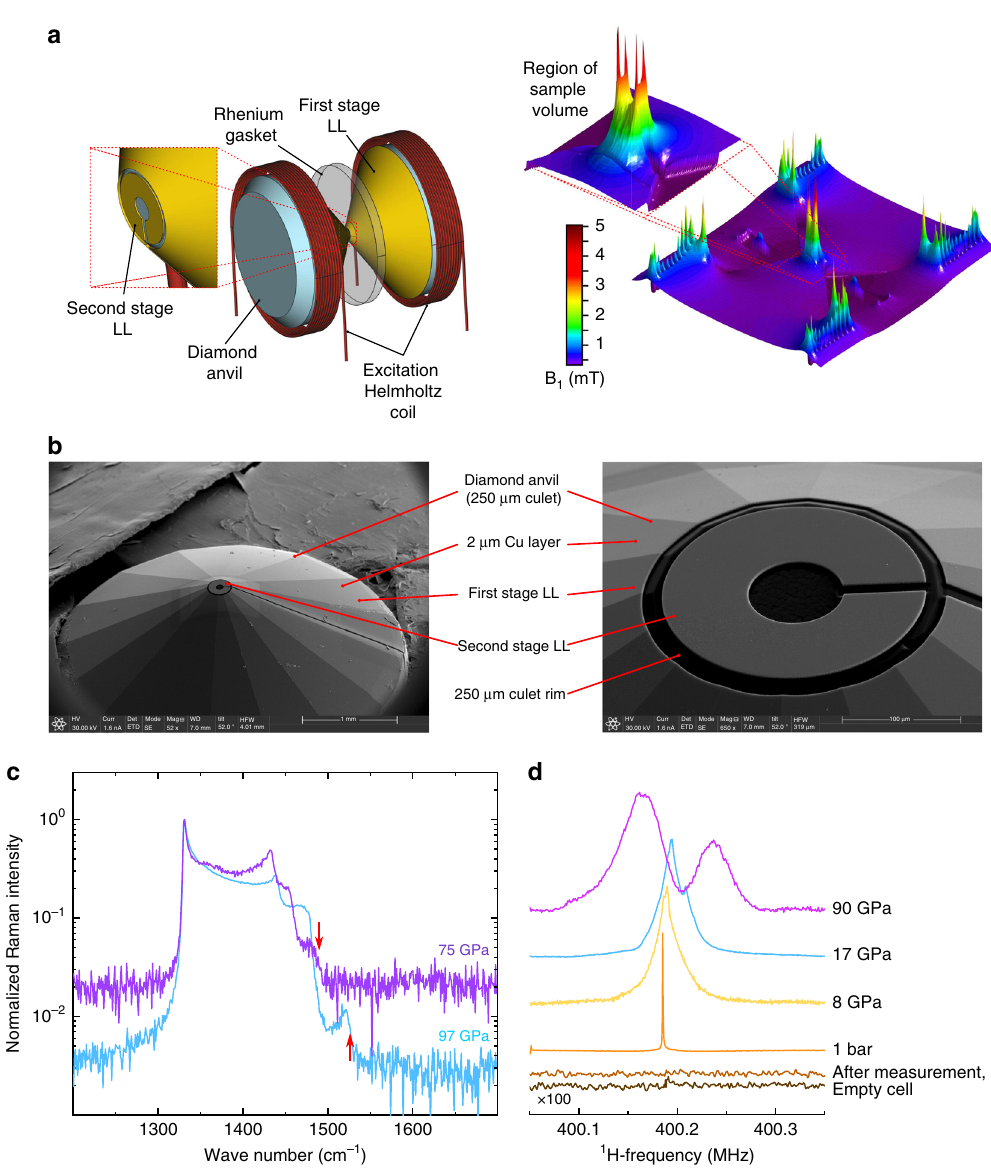
Fig. 2 Summary of the experimental setup. a High-pressure NMR resonator setup. The inset shows the zoomed-in region around the anvil's culet. Both Lenz lenses are formed on the anvil's pavilion by copper deposition and subsequent shaping, using a focused ion beam. Simulations of the RF magnetic fi eld generated by the resonator setup demonstrate the magni fi cation in B 1 at the sample cavity necessary for detecting NMR signals from the 100 pl sample cavity (80 µ m diameter, 20 µ m height prior to compression). b SEM images for the double stage Lenz lens (DSLL) resonator structure on one diamond. c Raman spectra accumulated at the diamond edge at the center of the sample cavity at pressures of 75 GPa and 97 GPa. Red arrows indicate the spectral position used for pressure determination. d Proton NMR spectra at different pressures as well as from empty cells, evidencing the origin of the acquired signals from the H 2 O samples from within the sample